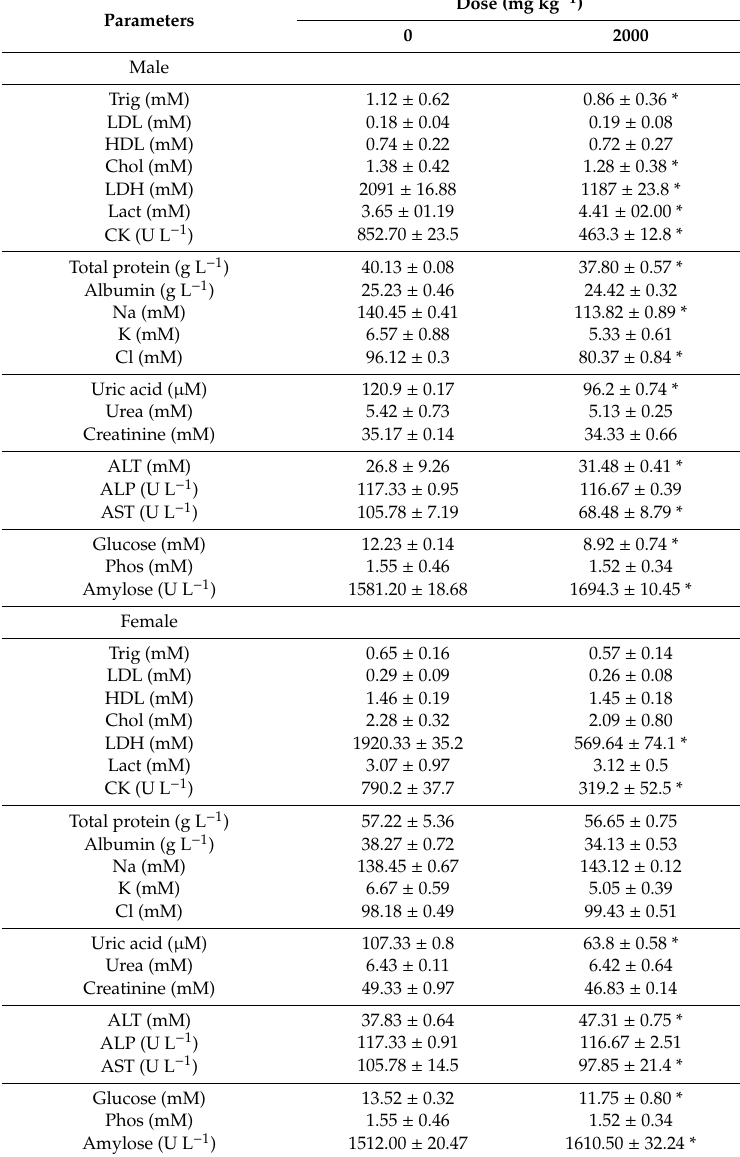
Table 4. Serum biochemical data for treated rats in a 14 d acute oral toxicity study. Data are means ± SD for groups of five animals per treatment. * ( p < 0.05) vs. control